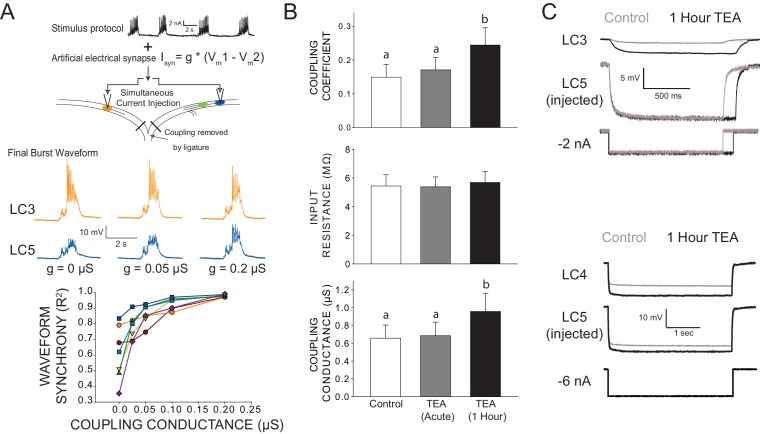
Changes in electrical coupling associated with compensation in biological CG networks.(A) Artificial electrical coupling restores synchrony in isolated LCs. With acute exposure to TEA, isolated LCs produce disparate output in response to an identical stimulus. The stimulus protocol consists of current injections that mimic biological synaptic currents and back propagating action potentials (see Ransdell et al., 2013a) from four consecutive bursts of network activity. The current was injected simultaneously into isolated cells, while the dynamic clamp was used to provide an artificial coupling conductance. Representative traces of the same two cells shown in TEA with different levels of synaptic current applied. Only the final burst of the four-burst input stimulus is shown for clarity. N = 7 different preparations (bottom panel) show an increase in synchrony with increasing coupling conductance. (B) Biological coupling increases during network compensation. Hyperpolarizing current injections were used to measure coupling coefficients between LC3 and LC5 during control conditions, with acute TEA exposure (5 min) and after 1 hr compensation in TEA. The input resistance of LCs was measured and showed no significant change at any time point. No significant differences were observed for coupling coefficient or coupling conductance between control and acute TEA conditions. Coupling coefficient significantly increased after 1 hr in TEA (Mean increase 85 ± 82% from control, N = 11, p<0.01, Wilcoxon signed rank test). Measurements from LC4 and LC5 show that coupling conductance increased significantly as a result of 1 hr TEA exposure (mean increase 49.5 ± 36% from control, N = 13, p<0.001, Wilcoxon signed rank test). Significant differences across groups are denoted by different letters. Plots show mean ± SD. (C) Representative traces from two different preparations of changes in coupling observed before (Control) and after 1 hr of TEA exposure. Top traces are between LC3-LC5 and the bottom traces are between LC4-LC5. Measurements were made in two-electrode current clamp, and the current was injected into LC5. Because current injections were manually timed to occur between bursts of network activity, slightly different durations of current pulses occurred in the two recordings in the top recordings. Recordings from LC4-LC5 were used for coupling conductance measurements seen in panel B, as their close proximity allows for much less influence of electrotonic distance on calculations of conductance.